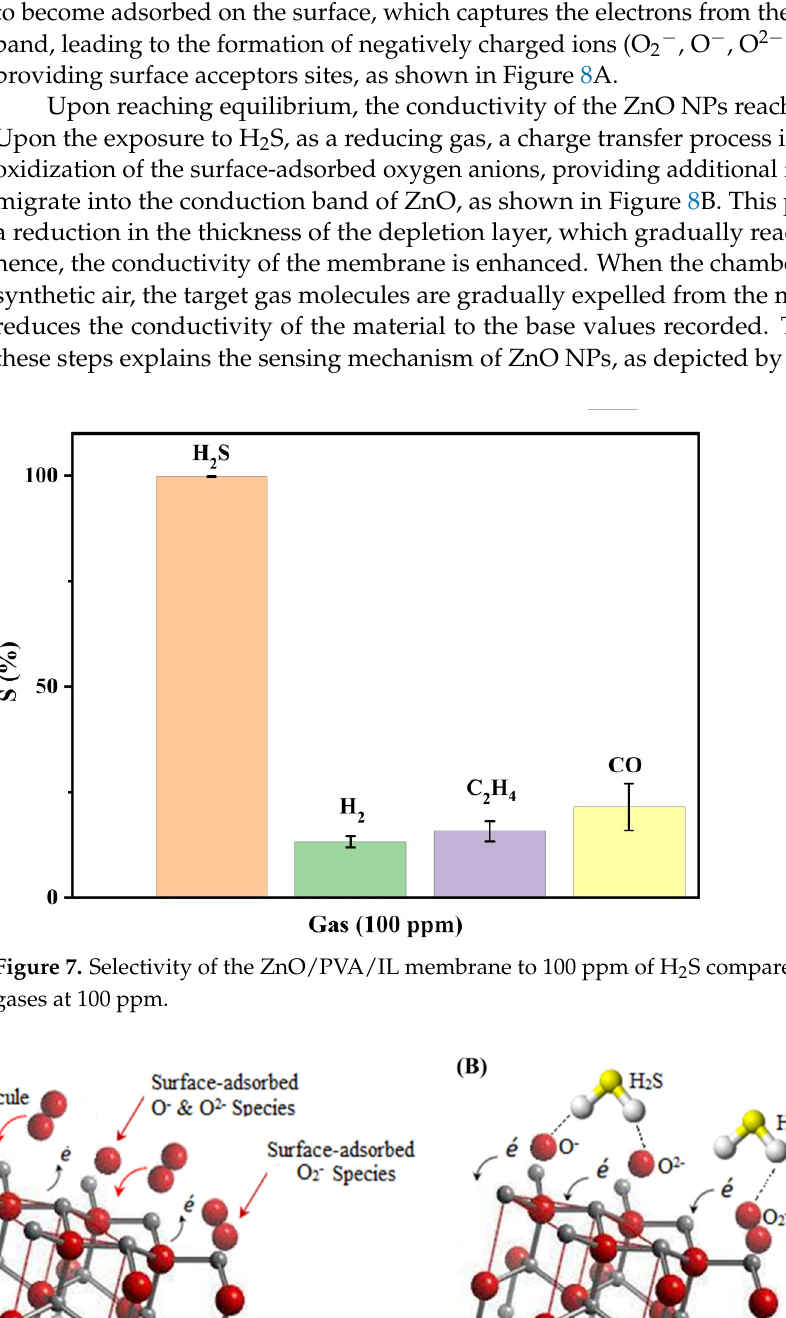
Figure 6. ( A ) Repeatability of the ZnO/PVA/IL membrane at 100 ppm H 2 S. ( B ) Long ‐ term stability of the ZnO/PVA/IL membrane for 21 days at 100 ppm H 2 S gas.